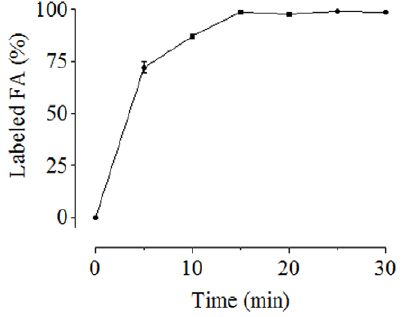
Figure 2. The efficiency of FA derivatization with AABD-SH. Fluorescence signal increases with time of incubation up to 15 minutes. Each point represents the percentage of tagged FA peak area measured by HPLC-FD. Data represent the means 6 SD of three independent experiments.